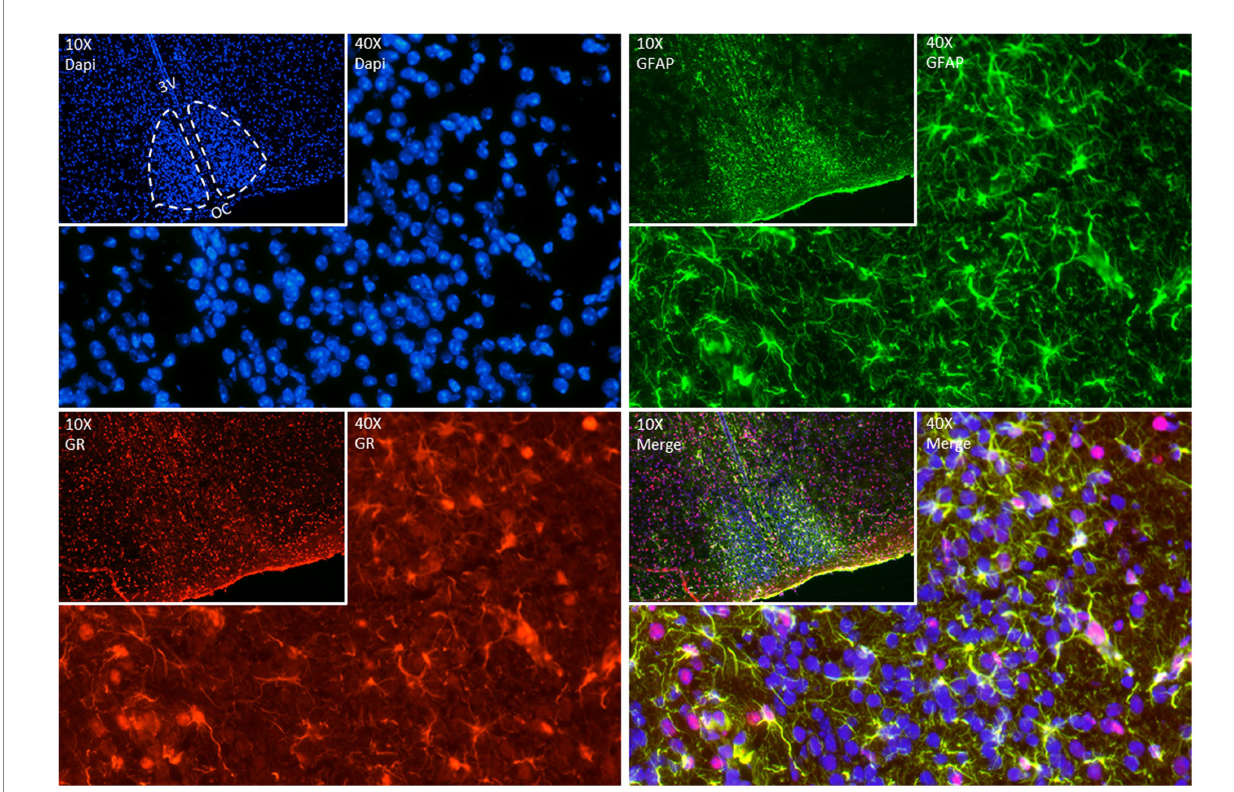
FIGURE 2 Representative double fluorescence immunostainings in the adult SCN. GFAP (green) used as an astrocyte marker, GR (red) and DAPI (blue) as a nuclear marker. Brain was collected from a 90-day old mouse at ZT (Zeitgeber time) 7, immediately frozen on dry ice, and sectioned (12 μ m) in a cryostat. After fixation (20 min at room temperature (RT)), sections were blocked with goat serum 4% in phosphate buffer (PBS) containing 0.4% of Triton X-100 for 1 h at RT. Sections were incubated with anti-GR (Abcam Ab183127, 1:200 in blocking) for 2 nights at 4 ° C. Sections were incubated afterwards with anti-GFAP (ThermoFisher 14–9,892-82, 1:200 in blocking) for 1 night at 4 ° C. The day after, sections were incubated with secondary antibodies – goat anti-rabbit Alexa 594 (ThermoFisher A11012, 1:500) and goat anti-mouse Alexa 488 (ThermoFisher A11029, 1:500) in a dark chamber for 2 h at RT. DAPI staining was performed to stain nuclei by incubating slides with 300 nM DAPI (ThermoFisher D1306) in PBS for 2 min in the dark. Images of immunofluorescent staining were made using Nikon Ts2R-FL (10X (insets) and 40X